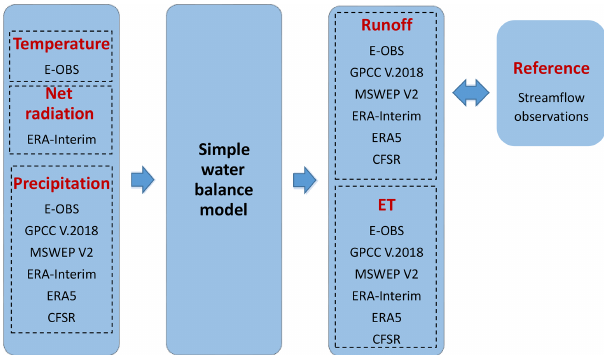
Figure 2. Overview of the modeling approach. The simple water balance model (SWBM) is forced with consistent net radiation and temperature data and six different precipitation data sets. The ob- tained runoff and evapotranspiration are assessed in terms of the variability between the simulations. The performance of the runoff simulations is determined against streamflow observations.